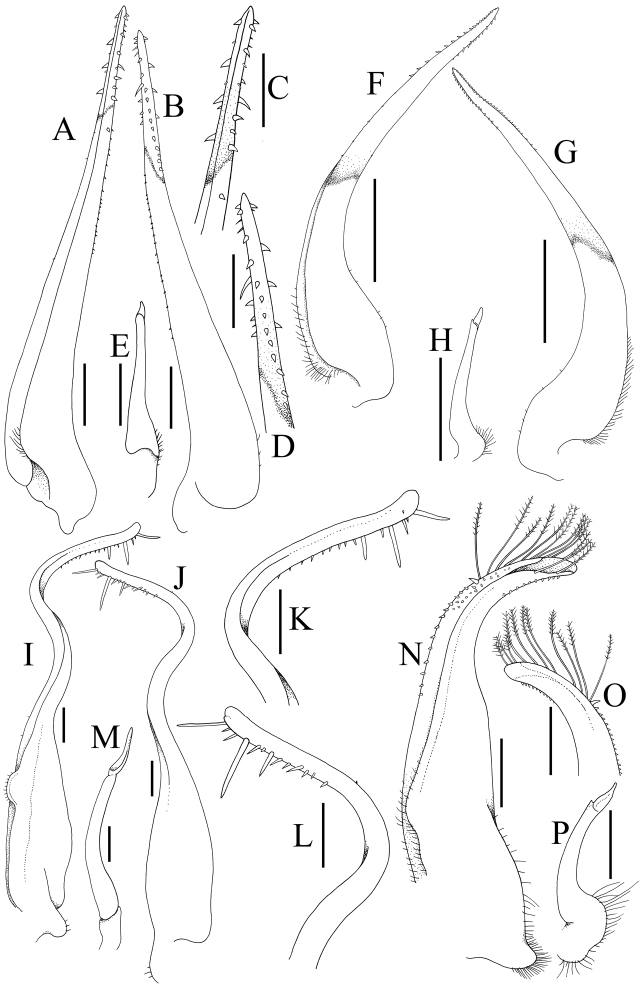
Gonopods. A–ENectopanoperhodobaphes Wood-Mason in Wood-Mason & Alcock, 1891, male (18.4 × 14.7 mm) F–HHenicoplaxmaldivensis (Rathbun, 1902), male (9.9 × 6.3 mm) I–MCryptopodiacollifer Flipse, 1930, male (17.5 × 10.6 mm) N–PParaxanthodescumatodes (MacGilchrist, 1905), male (8.3 × 5.5 mm). A, F left G1 (ventral view) B, G left G1 (dorsal view) C distal part of left G1 (ventral view) D distal part of left G1 (dorsal view); left G2. Scales bars: 0.5 mm (A, B, E–H–P); 0.25 mm (C, D).